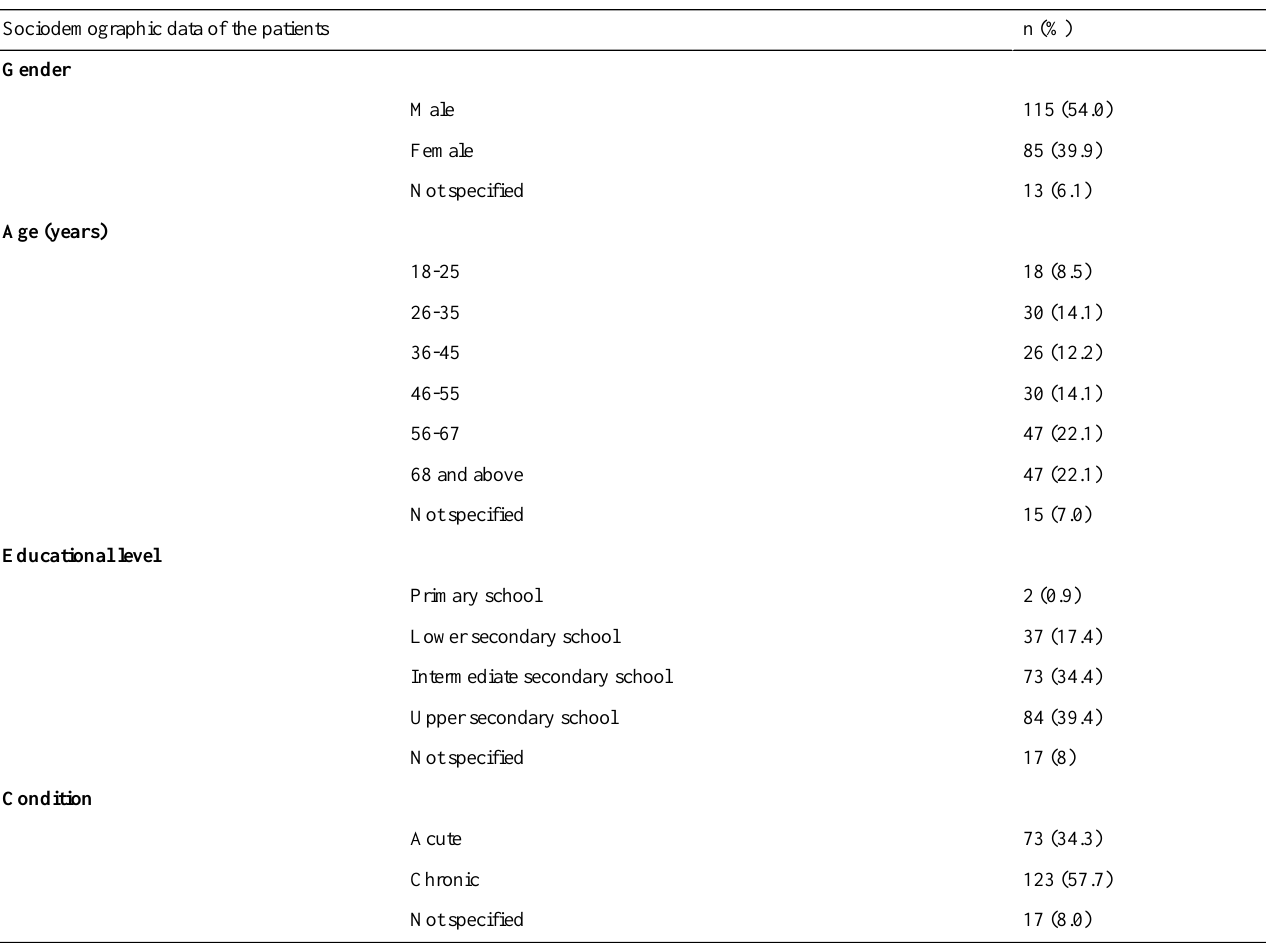
Table 2. Demographics of the patients (n=213) participating in the